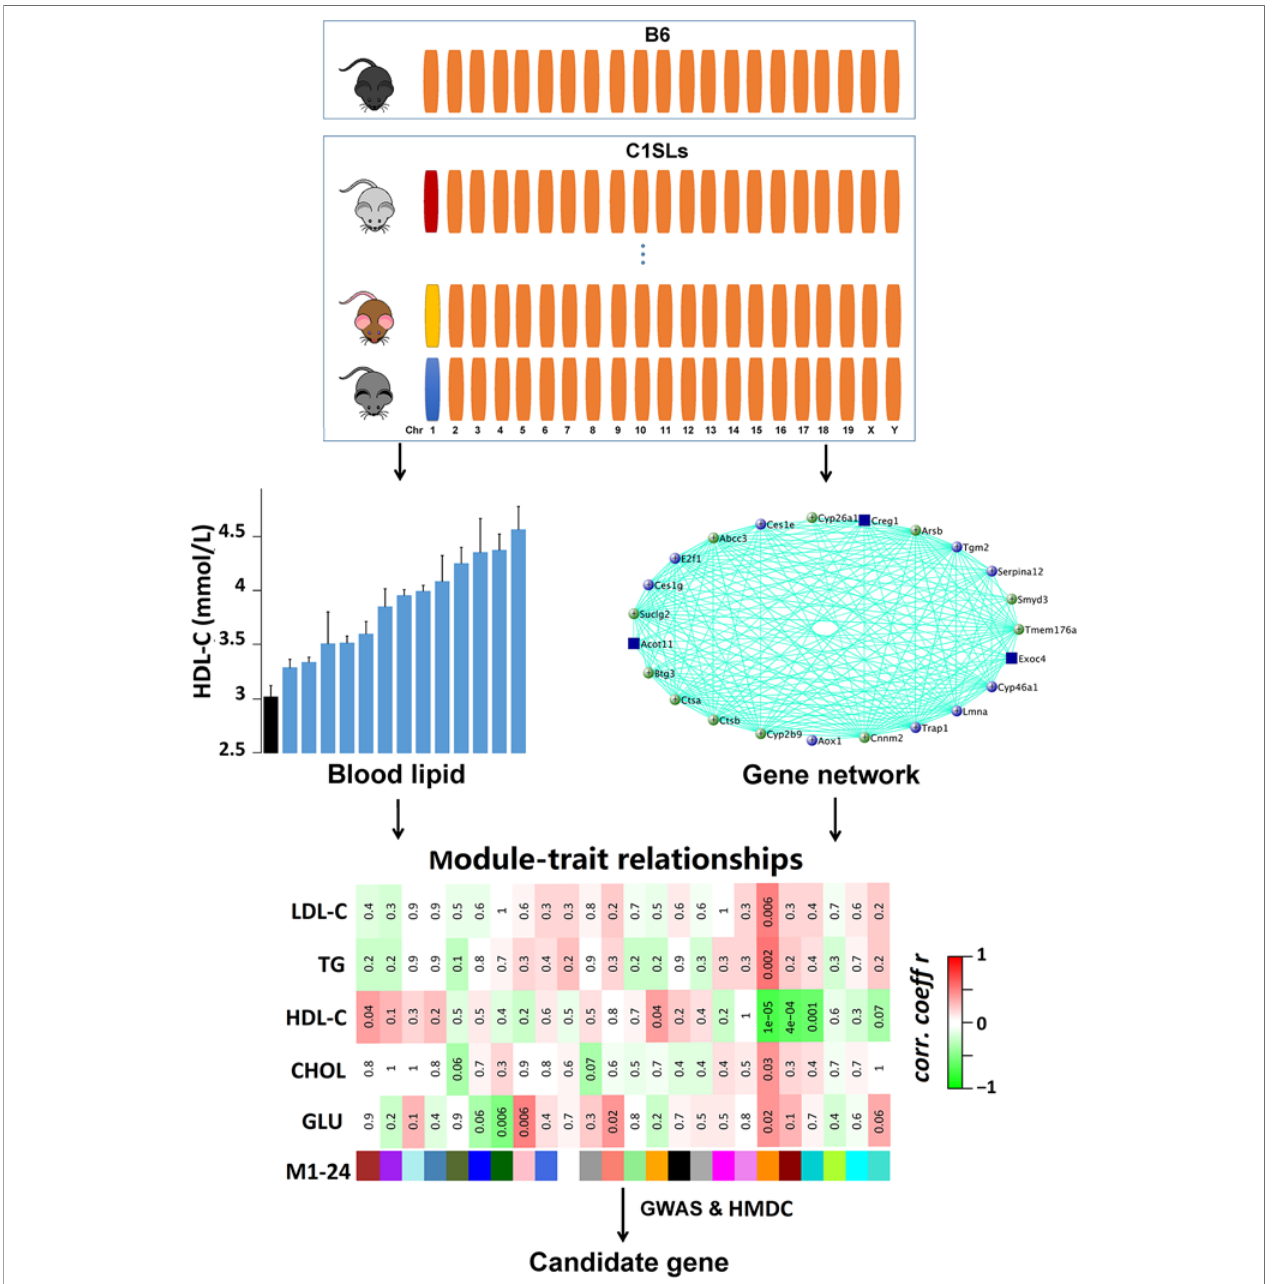
FIGURE 1 | Schematicofthe methodology.A total of14 strains (13 C1SLs andone recipient strain B6) were involved in this study. The upper panel shows the characteristics of C1SLsgenome background. Orange bars represent B6 chromosome whilethe others represent different donor chromosomes from wild mice. Blood lipid andfasting glucose levelswere measured at 20 weeksof age. Liver gene co-expression network was constructed with WGCNA. The trait-associated modules were identi fi edthroughtesting the association between traits and MEs. The candidate genes were further dominated byintegrating human GWAS and HMDC